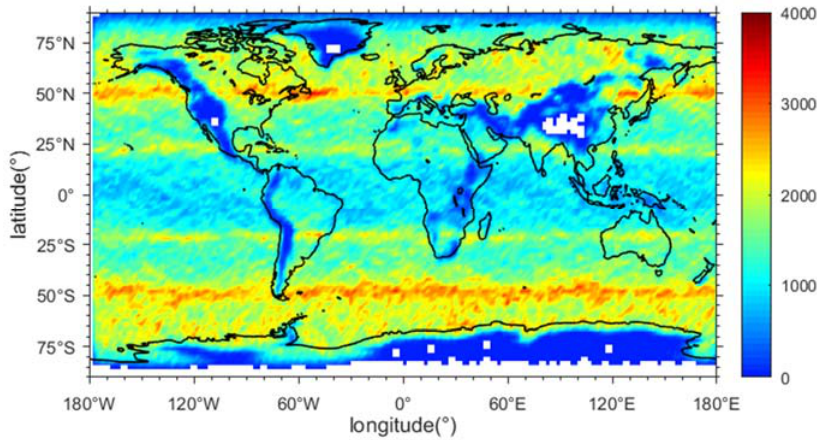
Figure 3. The global distribution of the data count within the 2_deg by 2_deg grid.